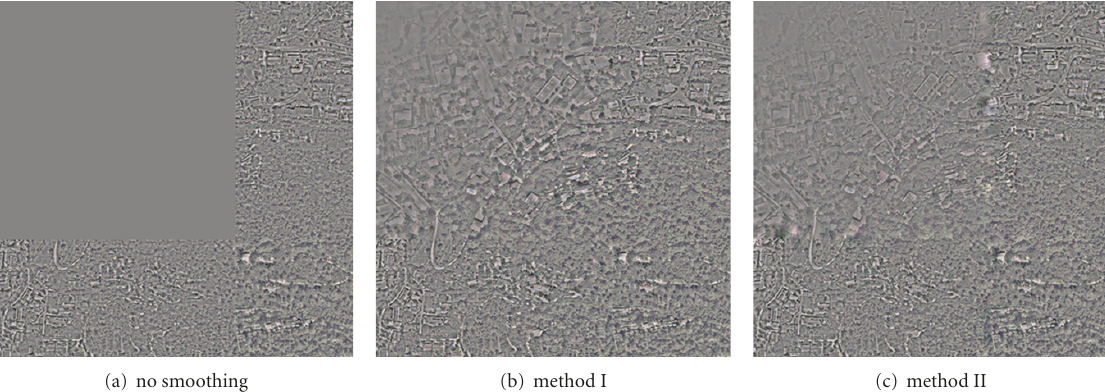
Figure 12: Di ff erence images with the original full-resolution tessellation detail.